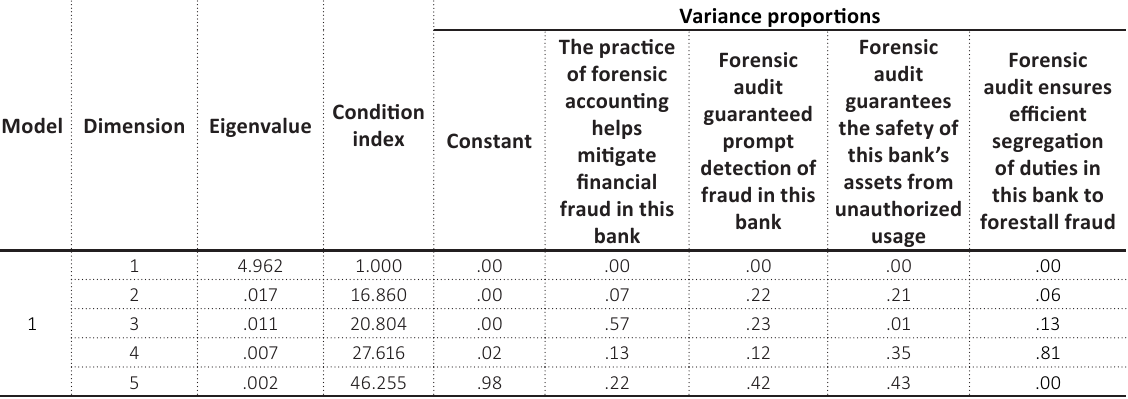
Table 5. Collinearity diagnostics a